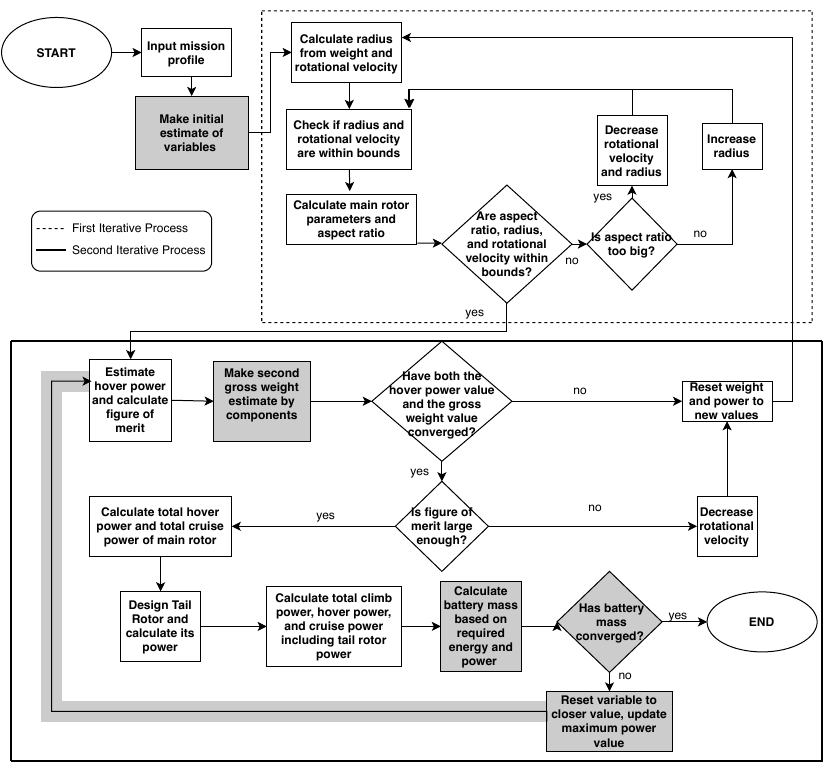
Figure 1. Flow chart of the updated conceptual design approach with the modified components highlighted in